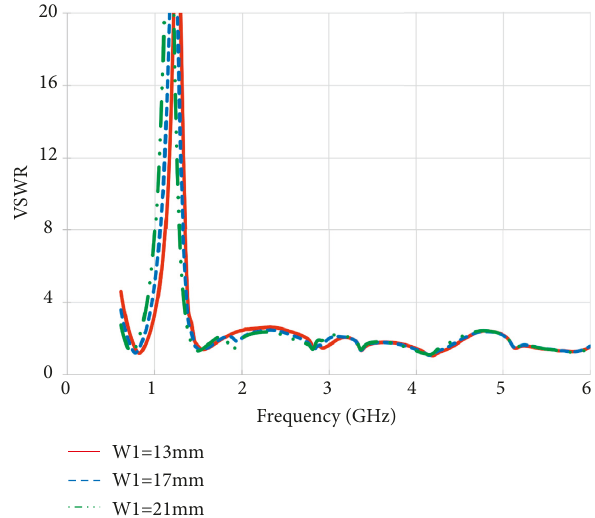
Figure 7: Effect of the long-branch horizontal folded arm width (W) on the antenna VSWR.